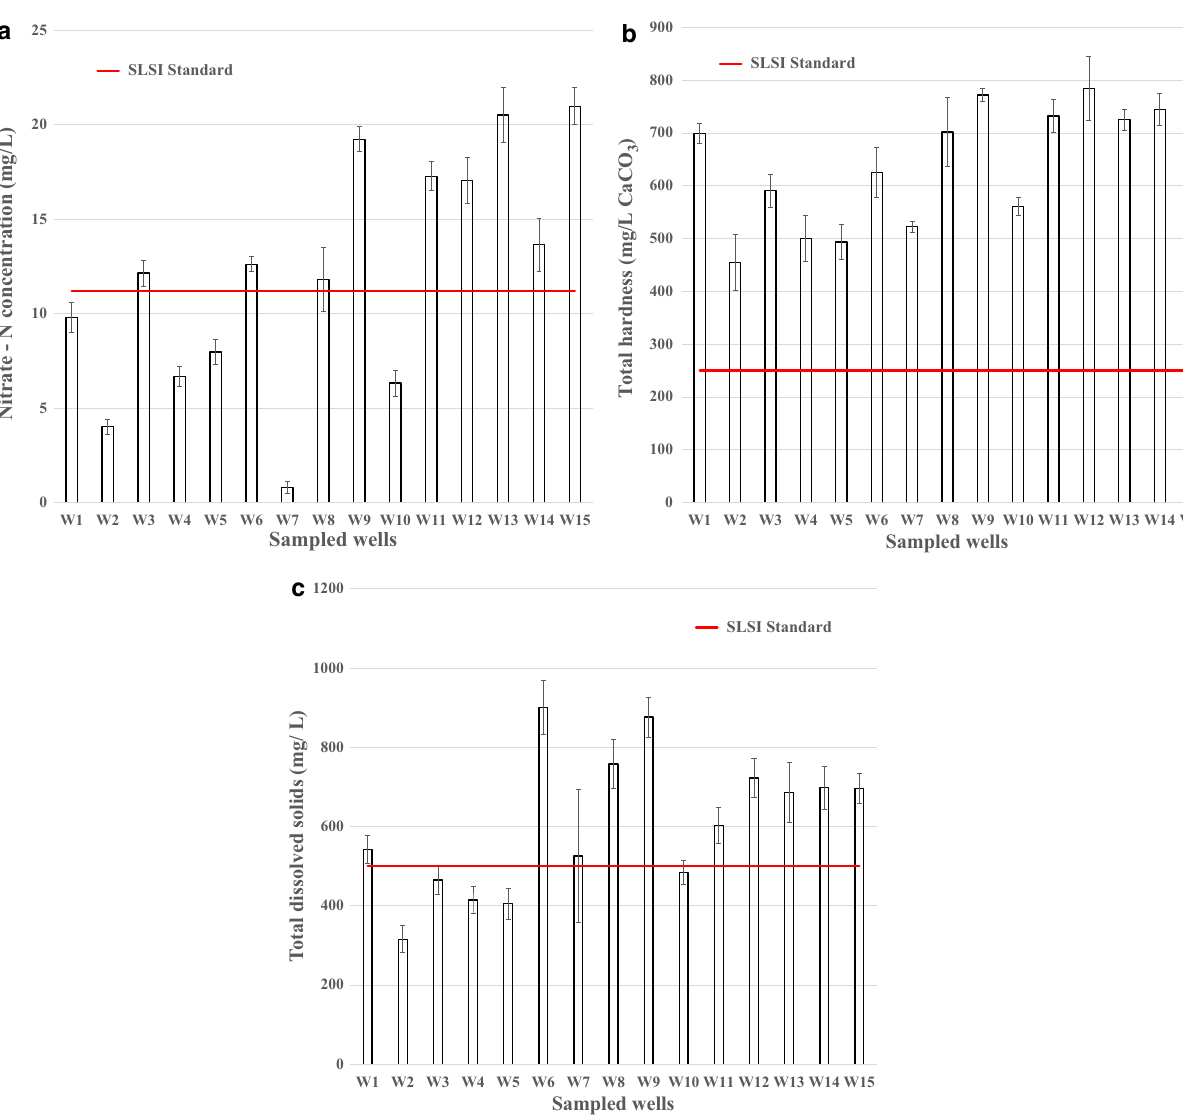
Fig. 2 The spatial variation of mean total hardness, TDS and nitrate N concentration of the sampled wells ( a : nitrate N concentration; b : total hardness; c : total dissolved